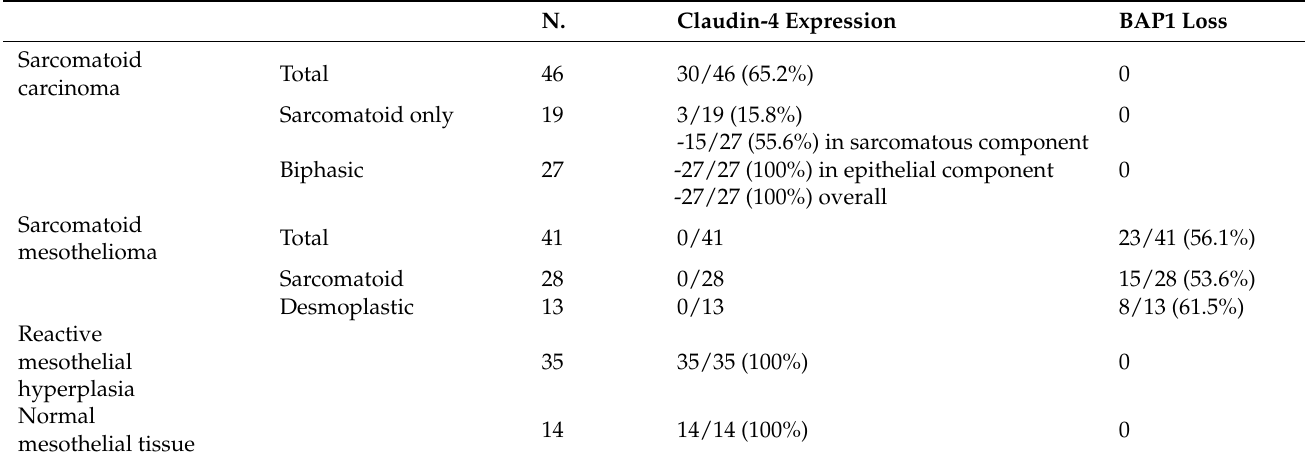
Table 2. Distribution of Claudin-4 and BAP1 immunostaining in the entire series. N.